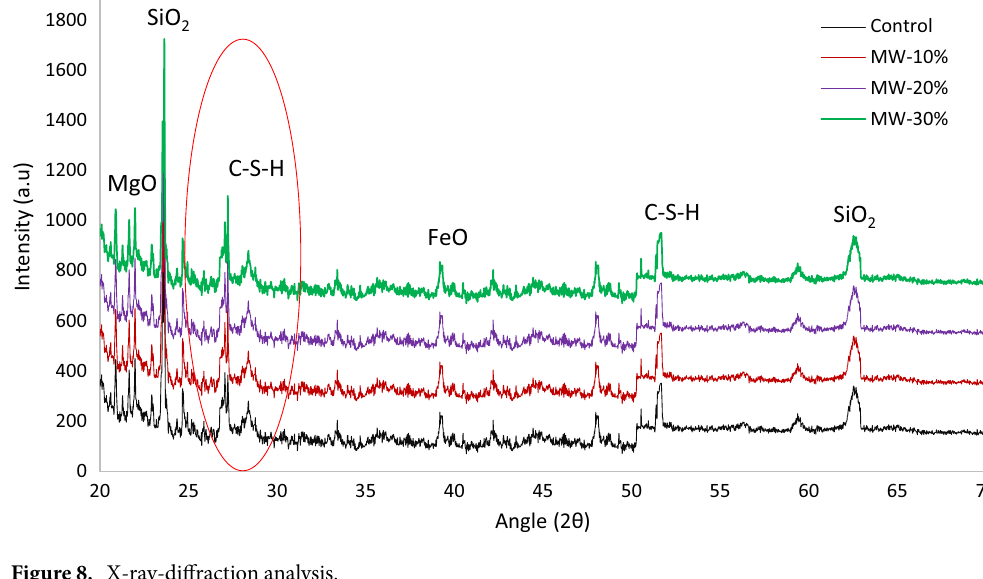
Figure 8. X-ray-diffraction analysis.